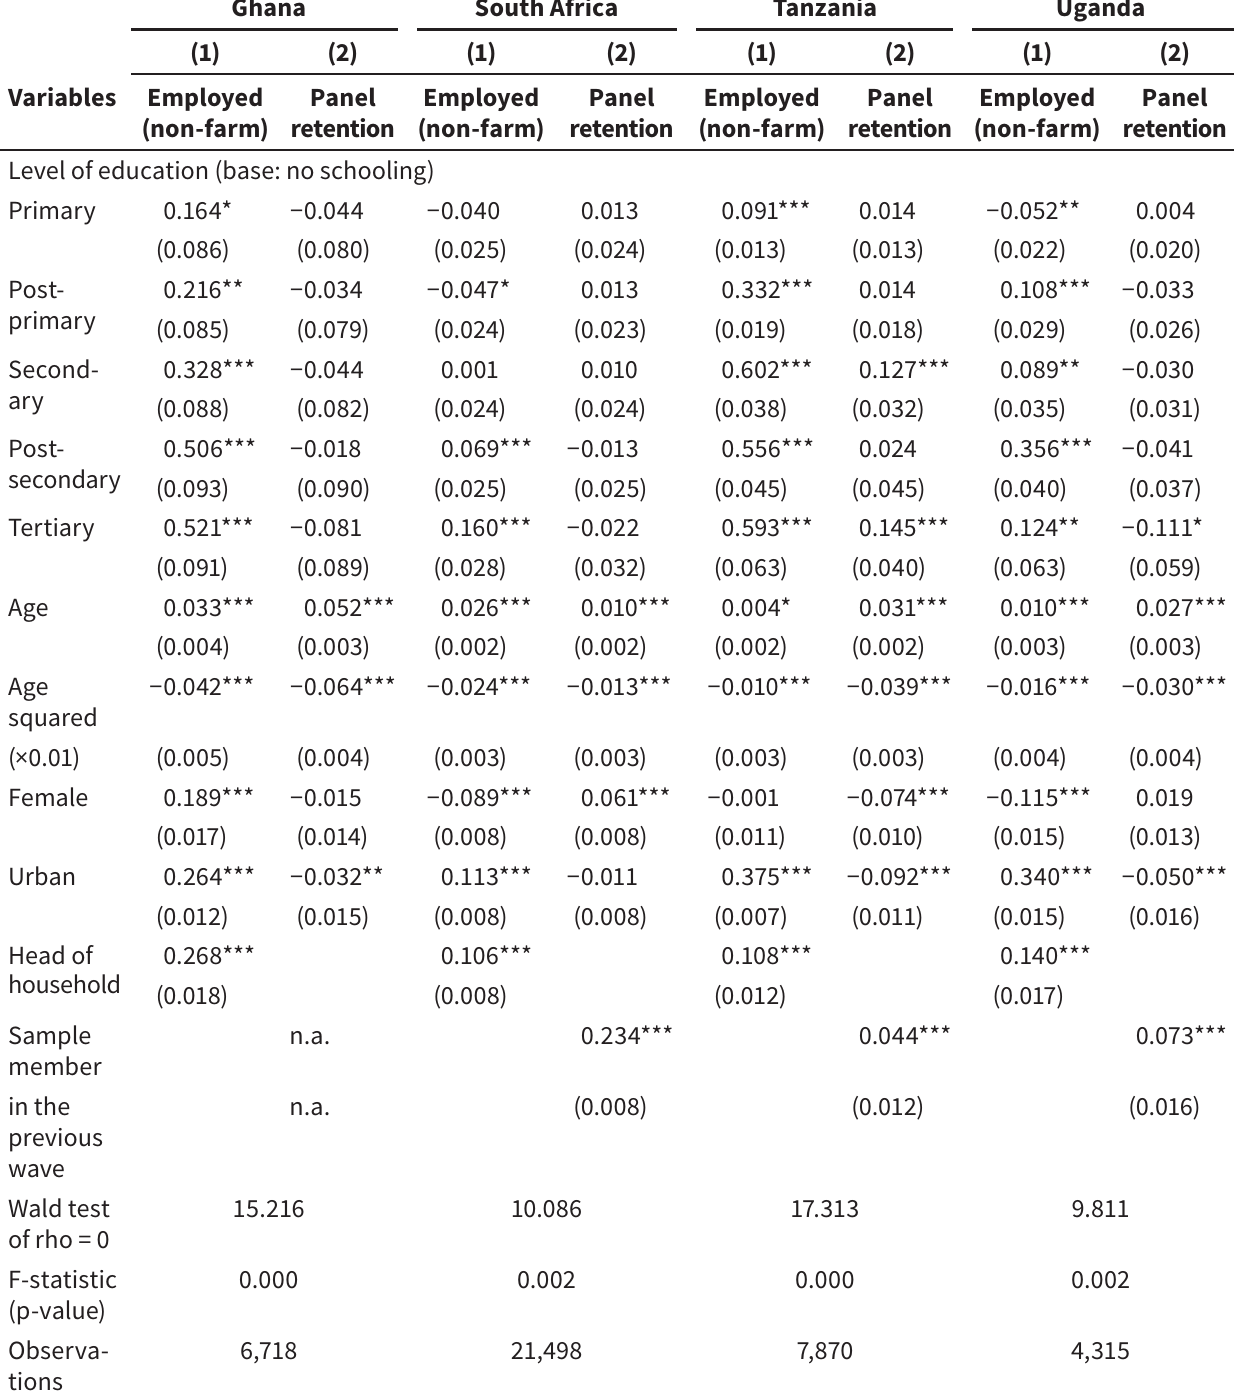
Table B7 Probability of employment (non-farm) in the baseline and panel retention